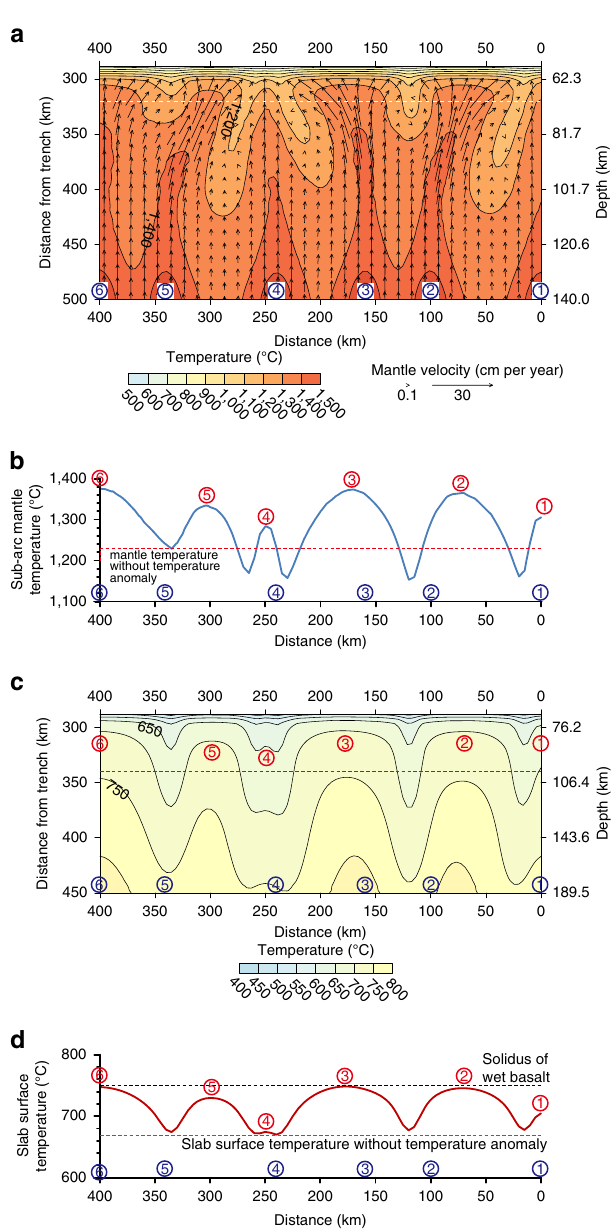
Figure 3 | Temperature and mantle flow field calculated from a model with six back-arc high-temperature anomalies. ( a ) Temperature distribution (colour) and mantle flow field (black vectors) on the dipping plane (indicated by the red dashed plane in Fig. 1a) calculated from a model with six high-temperature anomalies at 0, 100, 160, 240, 340 and 400km distance from the right side-wall (numbered from 1 to 6 enclosed by the blue circles, respectively). The temperature contours are at every 100 (cid:2) C. ( b ) Temperature (blue line) along the dipping plane at a depth of 70km (white dashed line in a ). ( c ) Temperature distribution (colour) on the slab surface. The temperature contours are at every 50 (cid:2) C. ( d ) Slab-surface temperature (red line) measured at a depth of 100km (red dashed line in c ). The black dashed line indicates the solidus of wet basalt 34,35 . The green dashed line indicates slab-surface temperature from the model without the back-arc high-temperature anomaly. Numbers enclosed by the blue and red circles in b – d indicate the locations of the back-arc high temperature anomalies and peak sub-arc mantle temperatures,